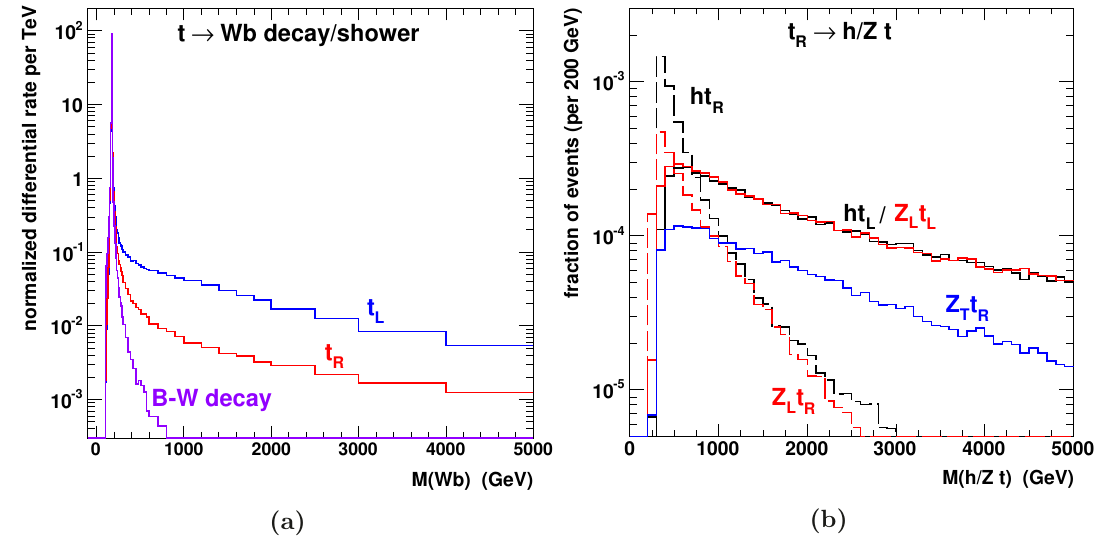
Figure 6. Invariant mass distributions for EW splittings initiated by a 10 TeV polarized top quark (a) for t L Wb (top curve), t R Wb (middle curve) and a fixed-width Breit-Wigner for → → unpolarized top decay without shower (lower curve); (b) for t R ht L /Z L t L , Z T t R (upper curves) → and to ht R , Z L t R (lower curves),